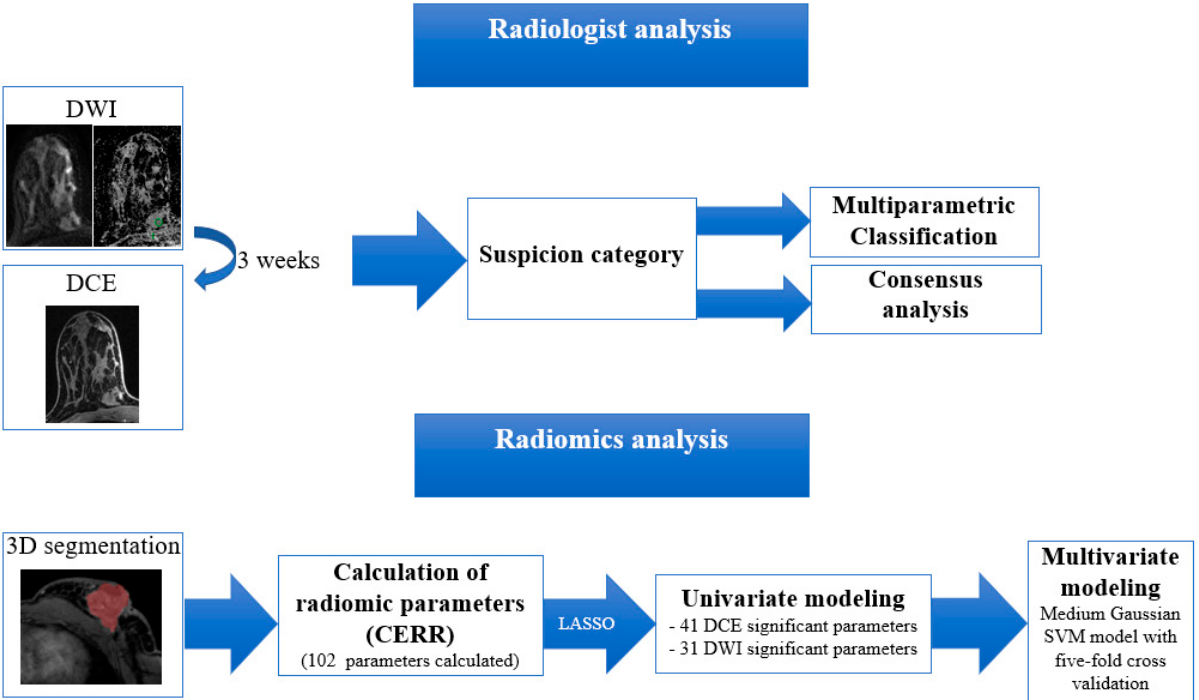
Figure 3. Workflow for the radiomics analysis. DCE-MRI, dynamic contrast-enhanced MRI; DWI, diffusion-weighted imaging; CERR, Computational Environment for Radiological Research; LASSO, least absolute shrinkage and selection operator; SVM, support vector machine.